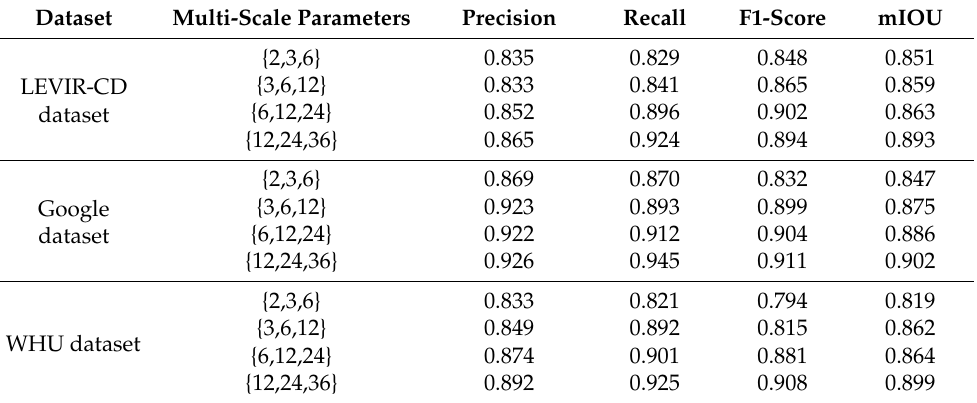
Table 4. Experimental results of building change detection comparison with different multi-scale